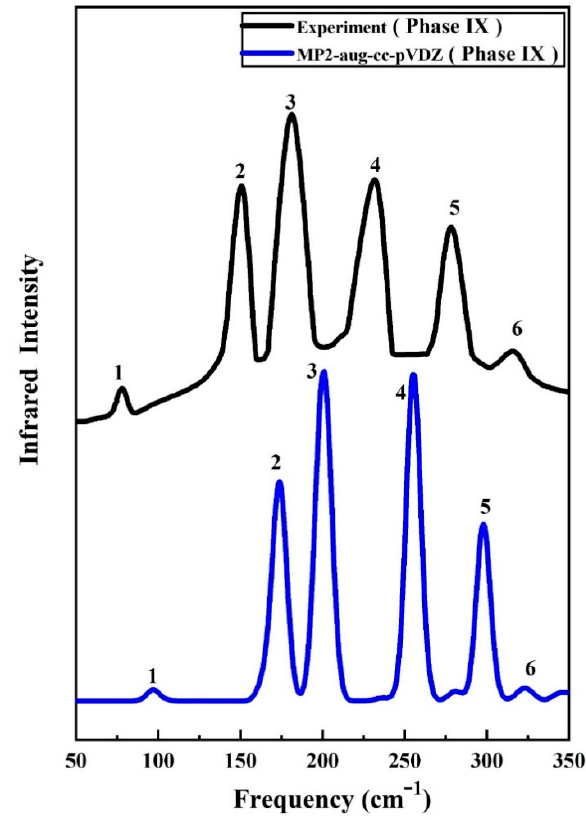
Figure 4. The calculated infrared (IR) spectrum of ice IX at 0.28 GPa, along with the experimental data taken from Ref. [46].